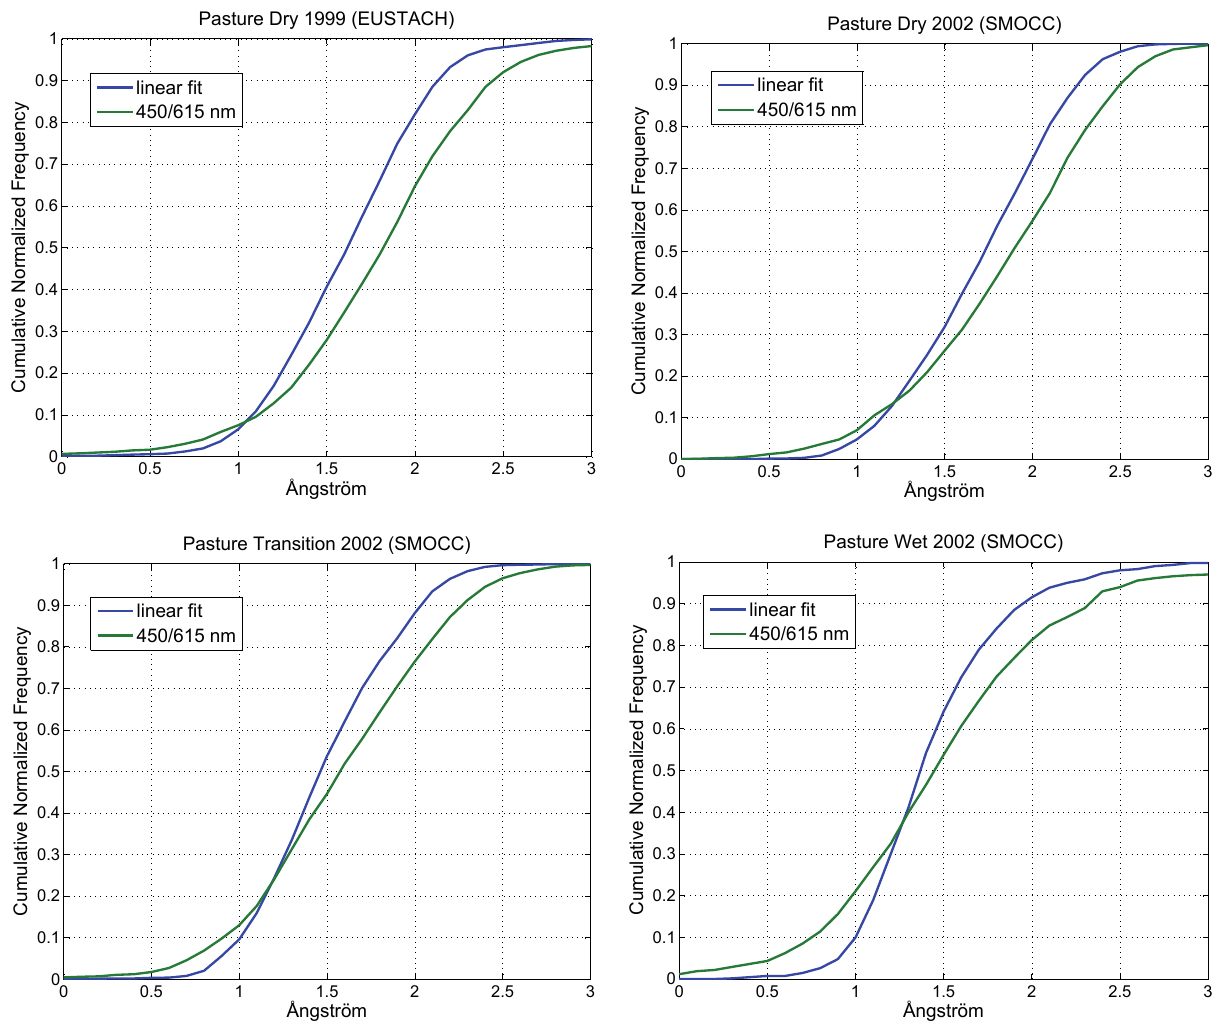
Fig. 7. Cumulative histogram of absorption ˚Angstr¨om exponents for: (a) Pasture Dry 1999 (LBA/EUSTACH); (b) Pasture Dry 2002; (c) Pasture Transition 2002 and (d) Pasture Wet 2002 (LBA/SMOCC). ˚Angstr¨om exponents were calculated based on the slope between ) and based on linear fits over the whole measured spectrum ( ˚a lin neighboring wavelengths ( ˚a 450 / 615 abs ± 20% (refer to Sect.